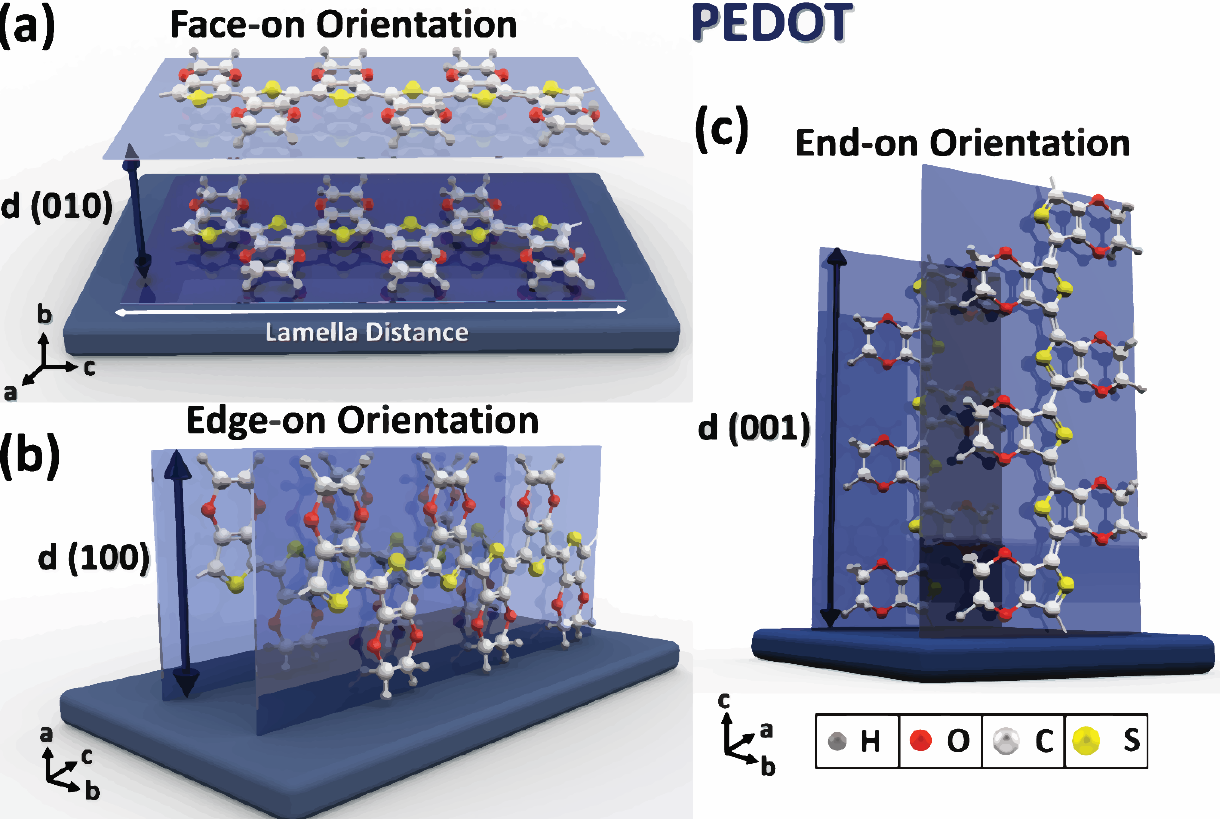
Figure 8. Display of three orientations in the PEDOT polymer: ( a ) face ‐ on orientation [12]; ( b ) edge ‐ on orientation [12]; and ( c ) end ‐ on orientation [1]. ( a , b ) Reproduced with permission [12]. Copyright 2019, Science. ( c ) Reproduced with permission [1]. Copyright 2020, Elsevier.